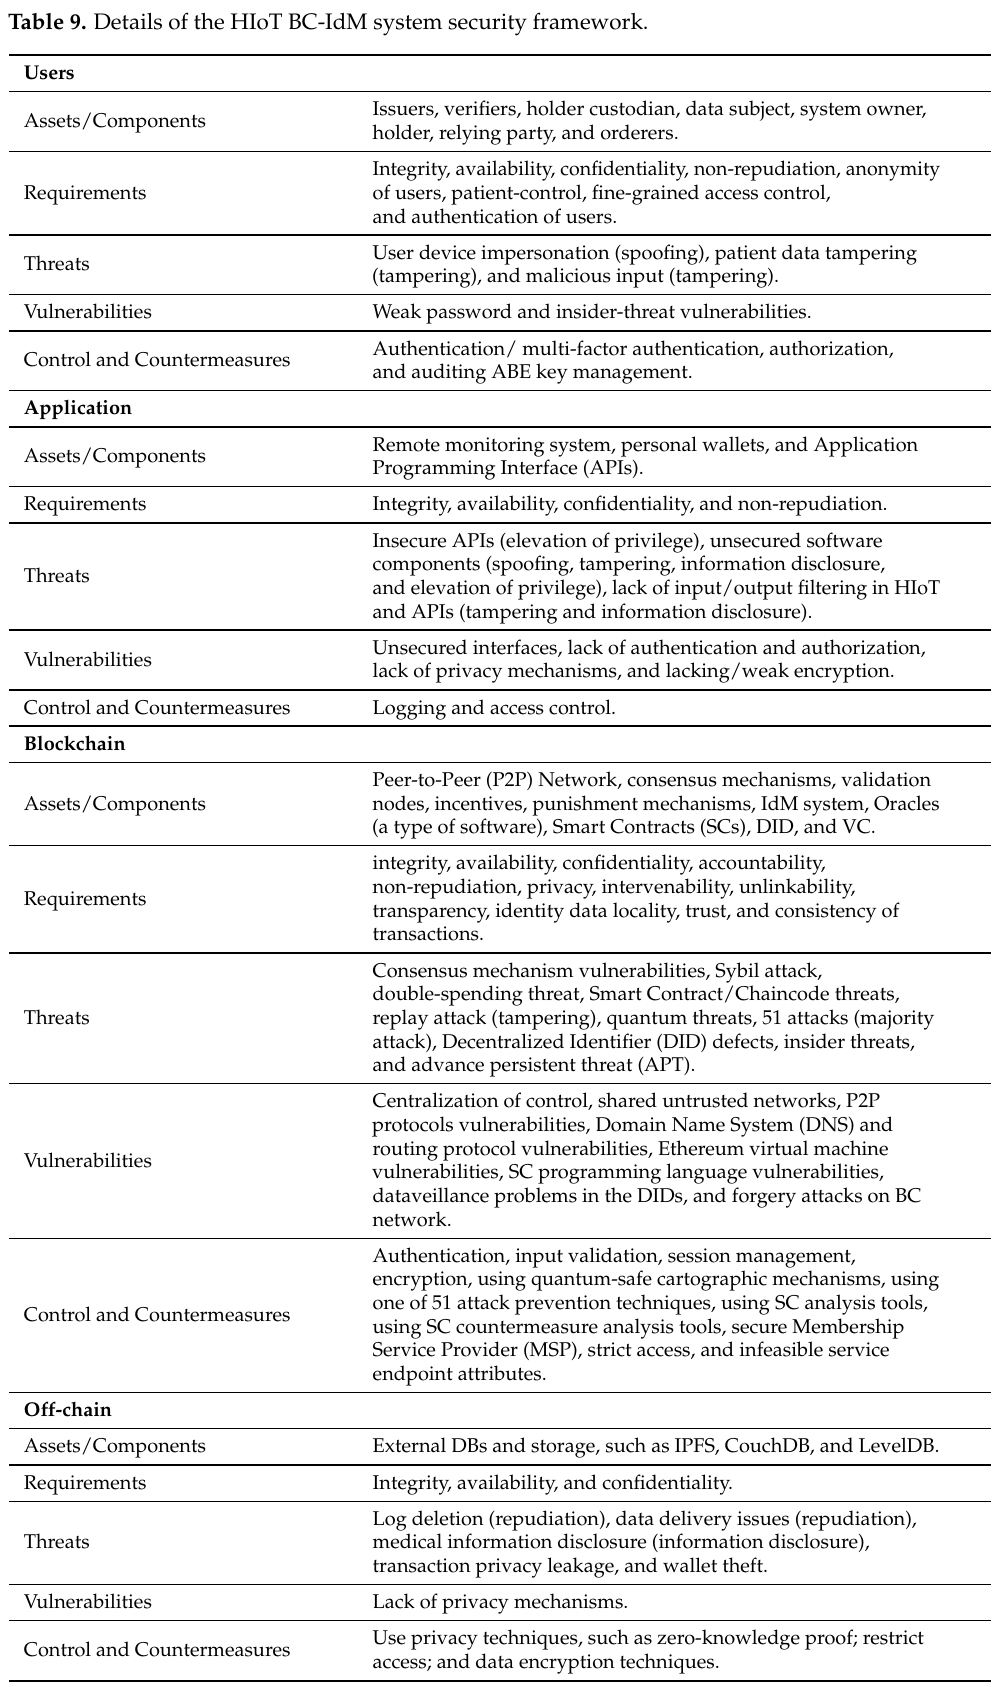
Table 9. Details of the HIoT BC-IdM system security